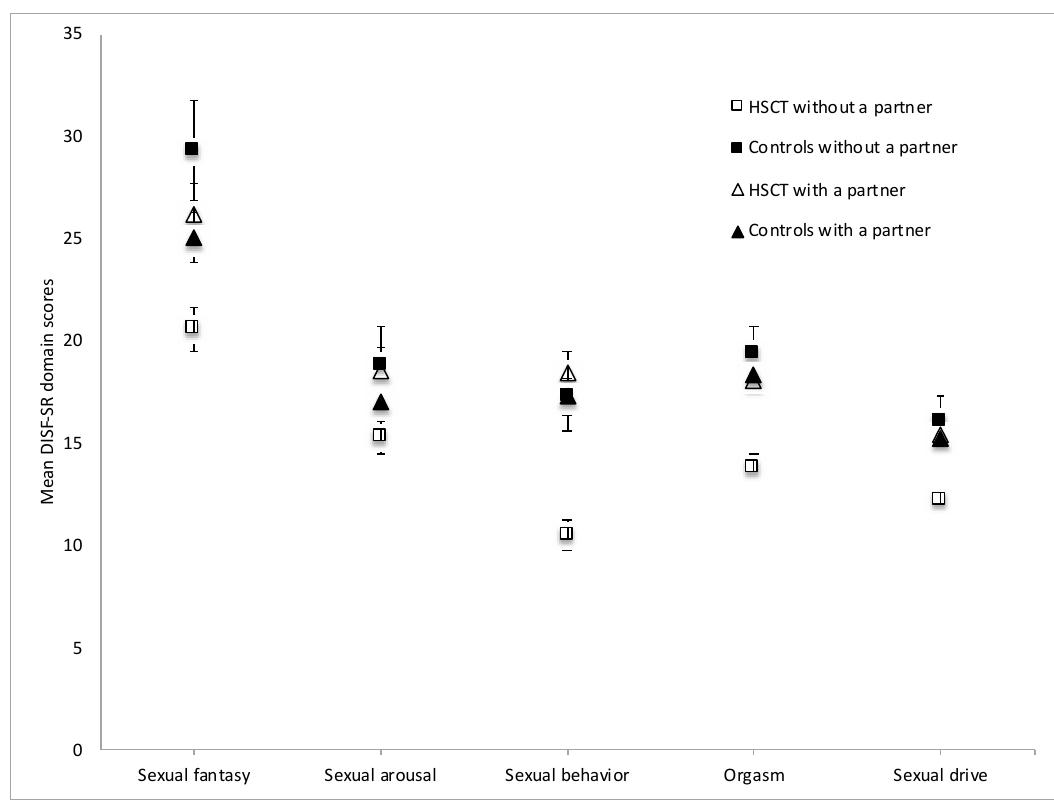
Figure 1. Mean scores on the Derogatis Interview for Sexual Functioning self-report (DISF-SR) in HSCT survivors and their controls categorized by partner status.